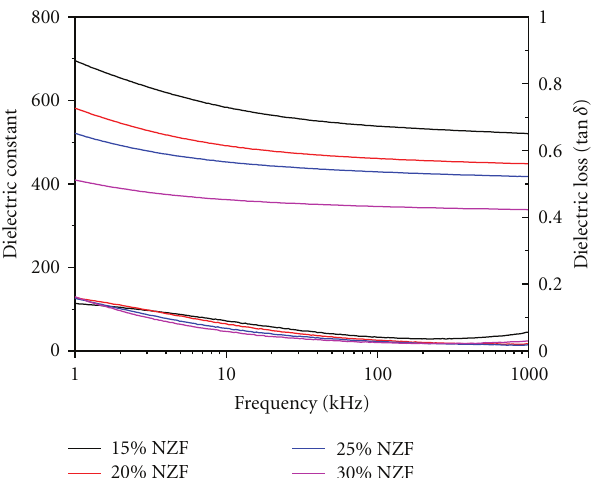
Figure 8: Dielectric constants and losses according to the frequency of PZT-PMnN + NZF nanocomposite films by AD as a function of NZF content, [72].